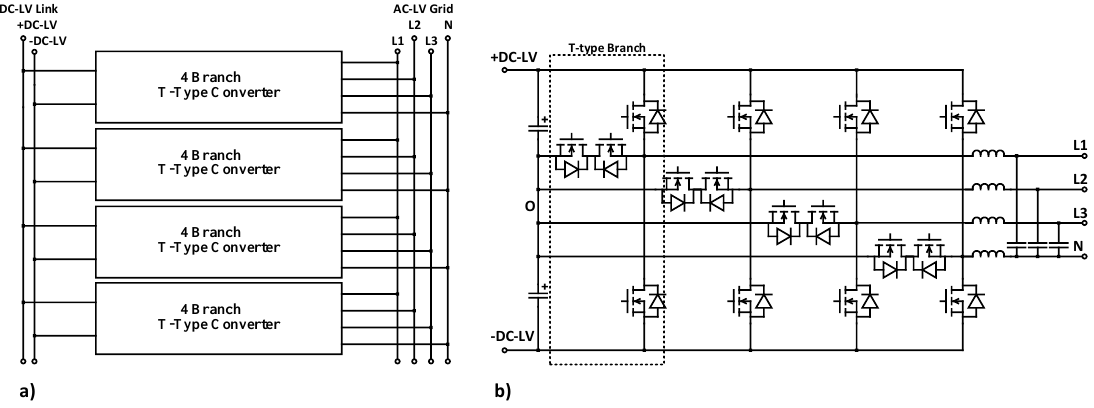
Figure 7. Considered DC-AC converter in the ST structure, composed of four T-type four-leg solutions, ( a ) the block scheme of the four T-type four-leg connection, ( b ) the model of the single T-type four-leg converter.